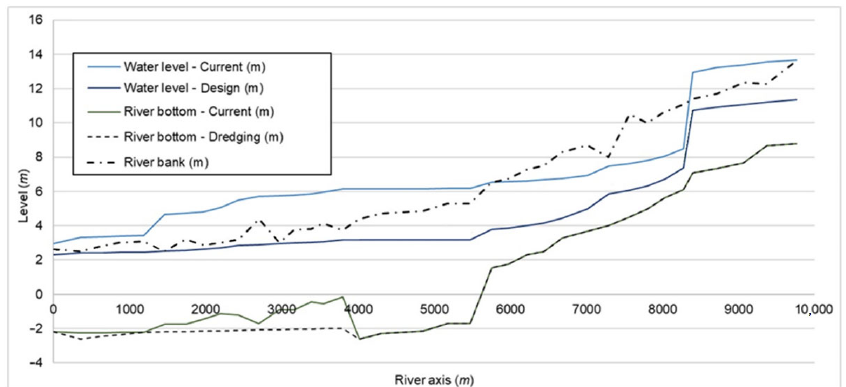
Figure 9. Profile of the main course of the Acari River—Current situation x Design Scenario.